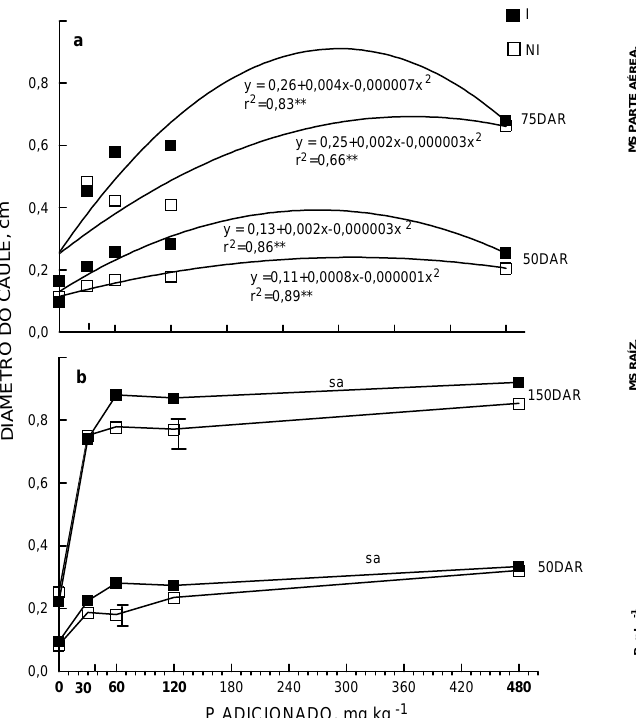
Figura 1. Diâmetro do caule da trema (a) e do fedegoso (b) em resposta a doses de superfosfato e à inoculação com o fungo micorrízico Glomus etunicatum (I- inoculado; NI- não inoculado), avaliado em diferentes dias após a repicagem (DAR). sa- sem ajuste de regressão para os modelos estudados. Barras verticais indicam a DMS a 5% para nível de P.